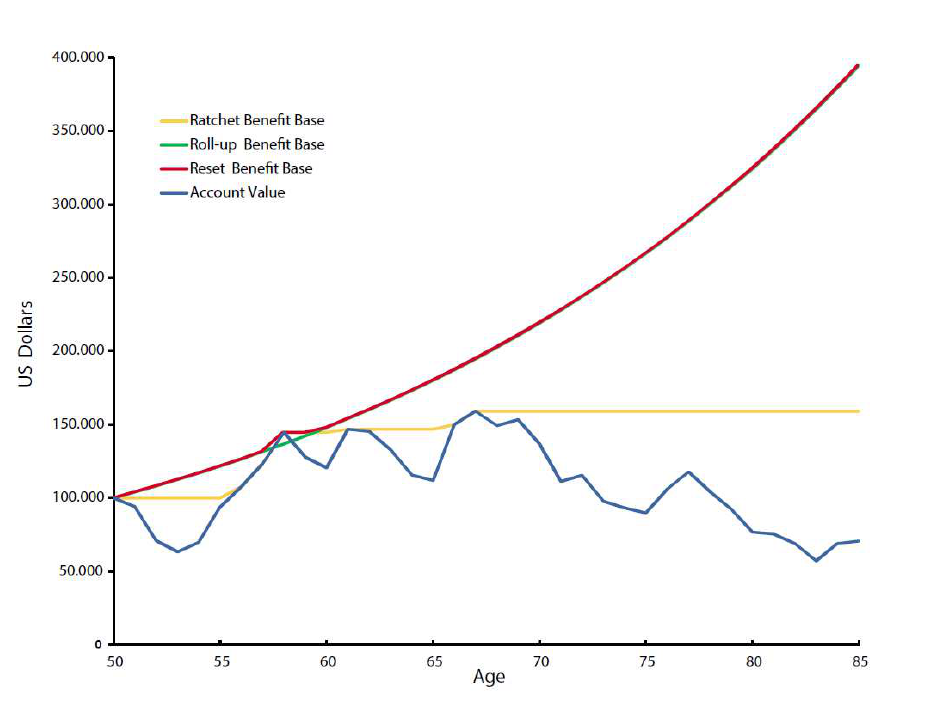
Figure 1. Behavior of the account value and the different options for the GMIB benefit base when no withdrawals have been